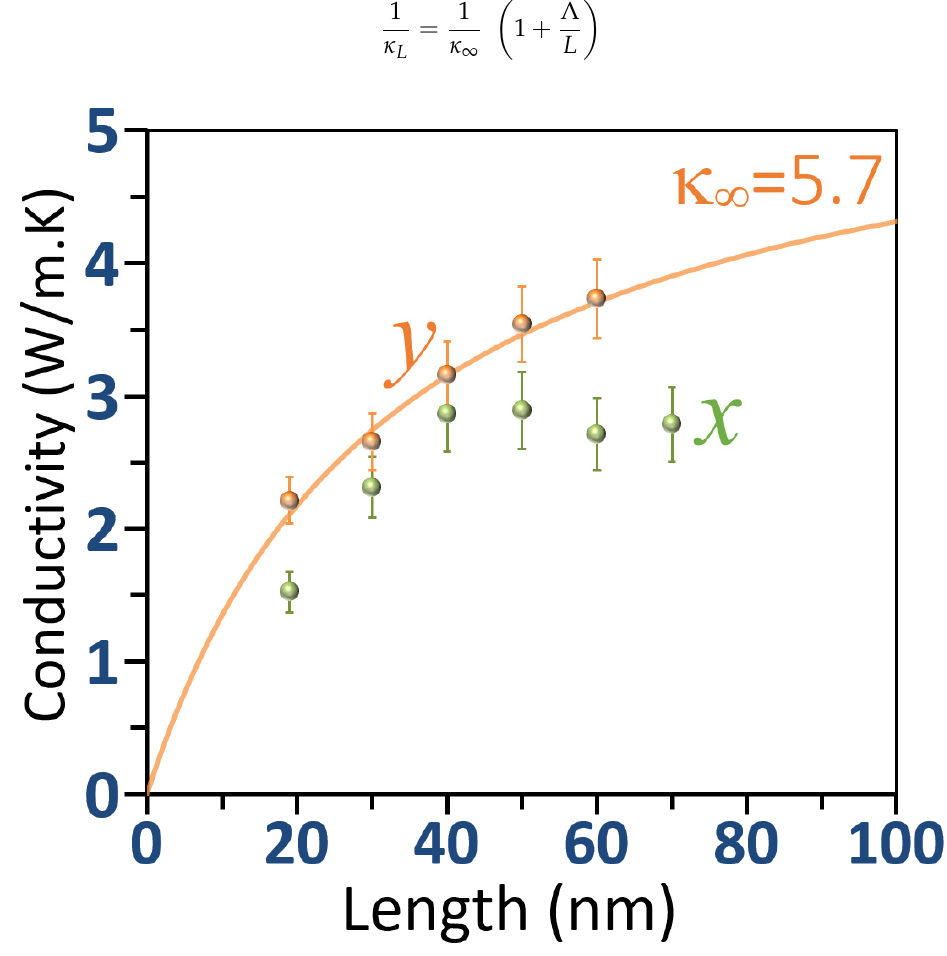
Figure 2. MTP-based NEMD results for the length and direction effect on the room temperature phononic thermal conductivity of the qHPC 60 monolayer. Continuous line is the fitted function according to Equation (1) to extrapolate the diffusive lattice thermal conductivity ( κ ∞ ). Using the aforementioned relation, the room temperature diffusive lattice thermal con- ductivity of the qHPC 60 monolayer along the y direction is predicted to be 5.7 ± 0.5 W/m · K (find the fitted line in Figure 2, which is almost twice of that along the x direction). As it is clear, this novel sp 2 –sp 3 -hybridized 2D carbon allotrope shows ultralow, by three orders of magnitude lower thermal conductivity than graphene [34], stemmed from high phonon scattering rates and low phonon group velocities. The combination of the semicon- ducting character with ultralow lattice thermal conductivity might be promising for the thermoelectric energy conversion, which requires a separate study. Last but not the least, we investigate the anisotropic mechanical response of the qHPC 60 monolayer by the MTP-based model, using systems with around 1000 atoms. As confirmed in our previous work [25,26,30,31,35], the MTP-based molecular dynamics simu- lations conducted at 1 K can closely reproduce the ground state DFT results. In Figure 3, the predicted direction-dependent uniaxial stress–strain responses of the qHPC 60